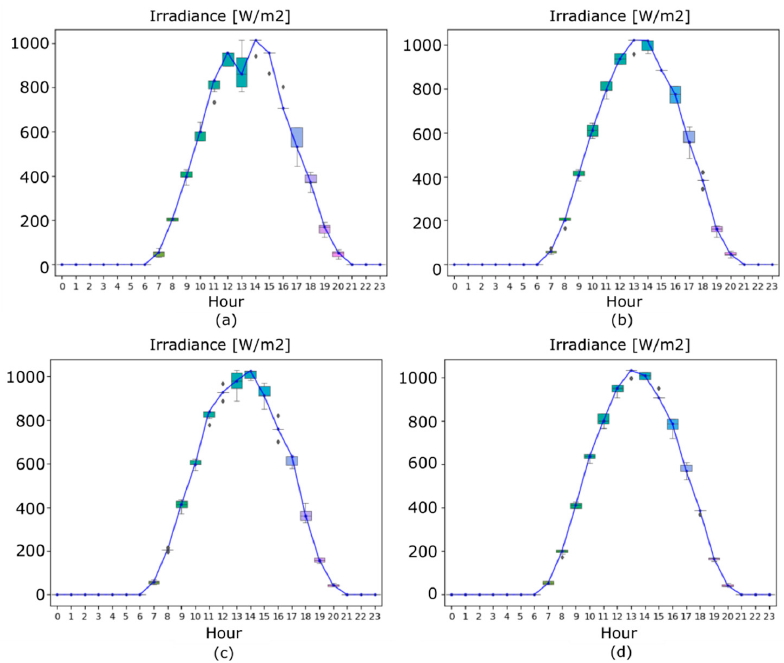
Figure 5. Median scenarios (blue) with box-whisker plot for scenarios generated for July using n S = 1000, n P = 10, n R = 7, and metric = (cid:96) 2 -Norm and varying p : 1.5 ( a ), 1 ( b ), 0.5 ( c ), and 0.15 ( d ).